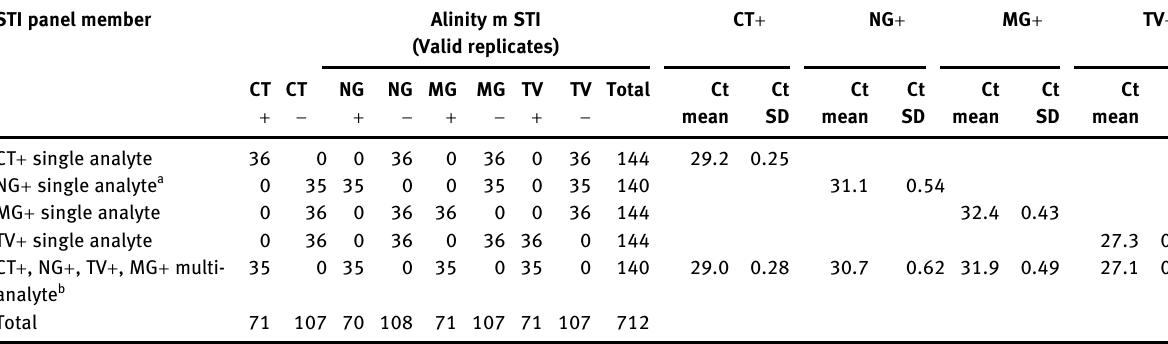
Table  : Analytical performance of the Alinity m STI assay tested with STI panels across study sites. STI panel member Alinity m